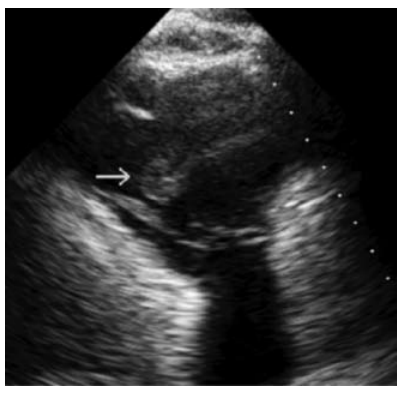
Figure 1. Right ventricular inflow view on echocardiogram showing a 2 cm ¥ 1 cm right ventricular mass (arrow).